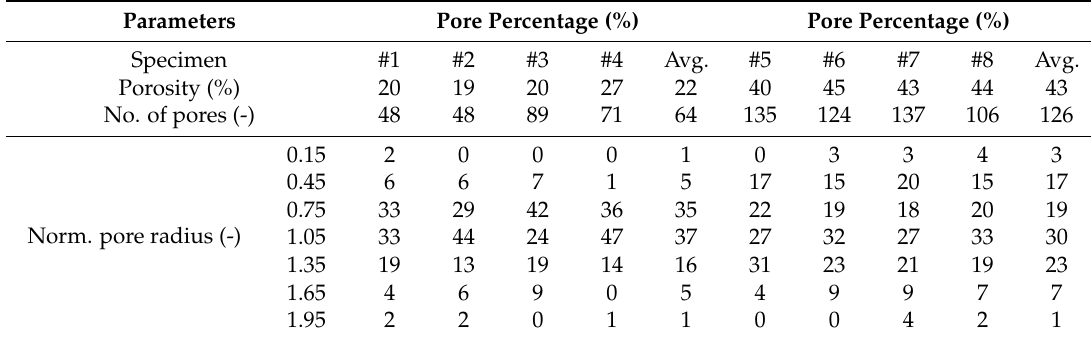
Table 1. Porosities, numbers of pores and pore percentages in the analysed lotus-type iron specimens with 22% and 43% average porosity. Parameters Pore Percentage (%) Pore Percentage (%) Specimen #1 #2